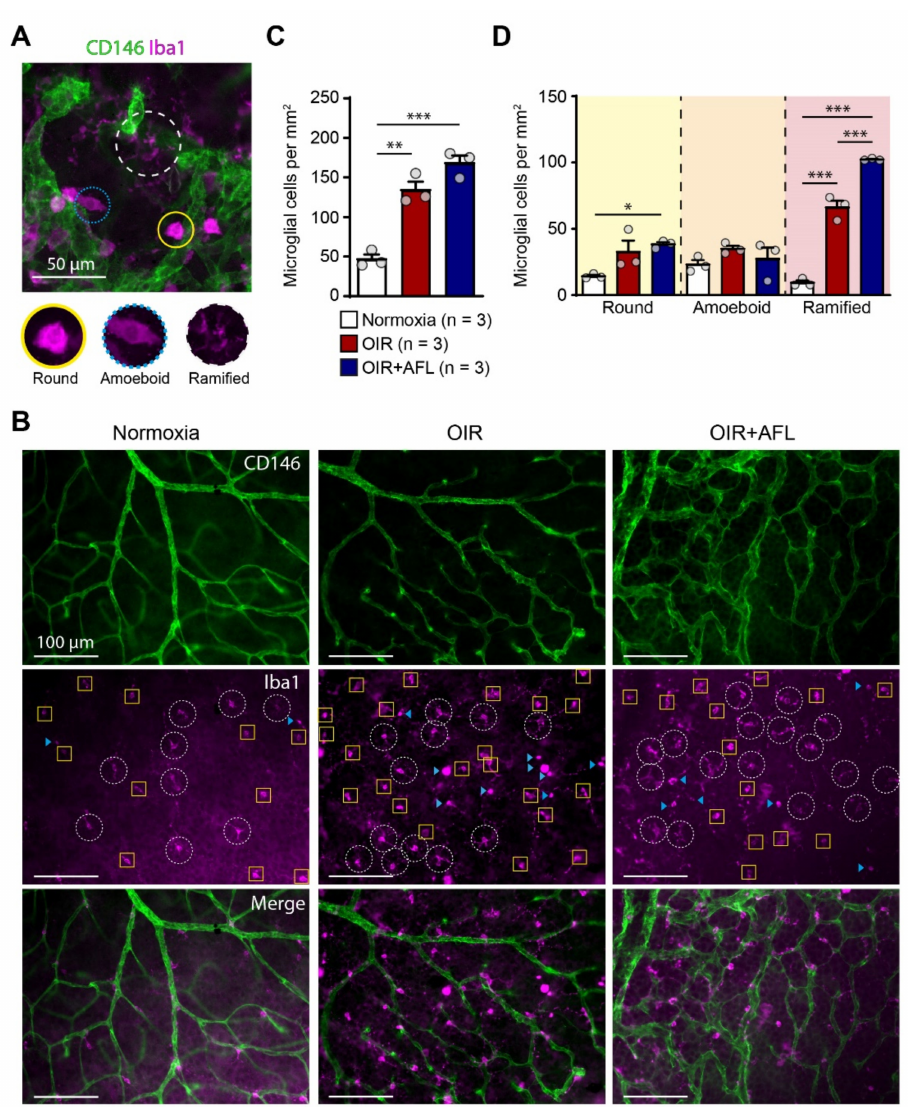
Figure 1. The proportion of ramified macrophage/microglial cells increases in retinas from OIR mice upon AFL treatment. ( A ) Representative micrograph of a CD146 (green) and Iba1 (magenta) immuno-fluorescently labeled retina from a P17 OIR+AFL mouse. CD146-positive structures in the image are neovascular tufts. Iba1 + cells were morphologically discriminated into round (solid line, yellow), amoeboid (dotted line, blue), and ramified (dashed line, white). Scale bar: 50 µ m. ( B – D ) Iba1 + cells were quantified according to their morphology in immuno-fluorescently labeled flat-mounted retinas from P17 normoxic (white), OIR (red) and OIR+AFL (blue) mice (n = 3 per treatment). Scale bar: 100 µ m. In ( B ), ramified cells are encircled by a white dashed line, round cells are labelled with a blue arrowhead, and amoeboid cells are enclosed in yellow squares. The images are representative of vascularized regions free of neovascular tufts. In graphs, the total number of Iba1 + cells ( C ), irrespective of their morphology, as well as the number of cells exhibiting each morphology ( D ), are shown as quantified in entire retinal flat-mounts. Error bars display +1 S.E.M. n.s., non-significant; * p < 0.05; ** p < 0.01, *** p <